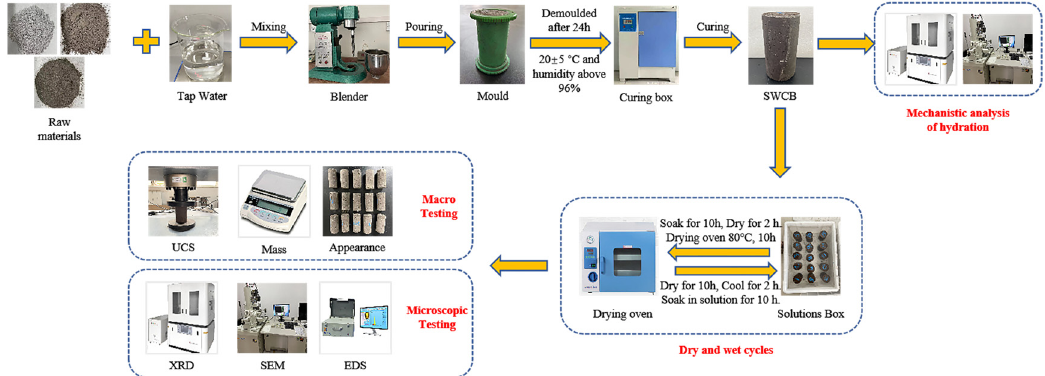
Figure 2. Experimental flow diagram. m 0i − m Ti ∆ m = × 100% (1) Ti m 0i The specimens were also subjected to SEM and XRD microscopic characterisation studies at the middle and late stages of testing. The crystal structure and composition of SWCPB were examined with X-ray diffraction (XRD) on a XRD-6100 X-ray diffractometer (Shimadzu, Kyoto, Japan) with Cu-K α radiation ( λ = 1.54056Å) at a rate of 4 ◦ /min in